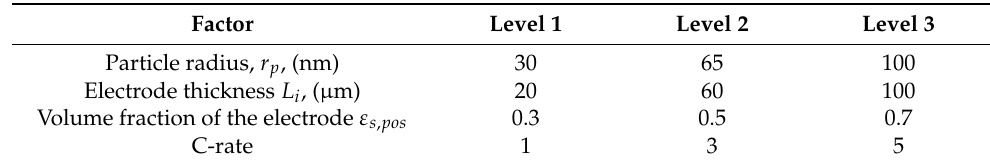
Table 1. Different factors and their range, used in the factorial design—positive electrode of a 10 Ah lithium phosphate (LFP) pouch